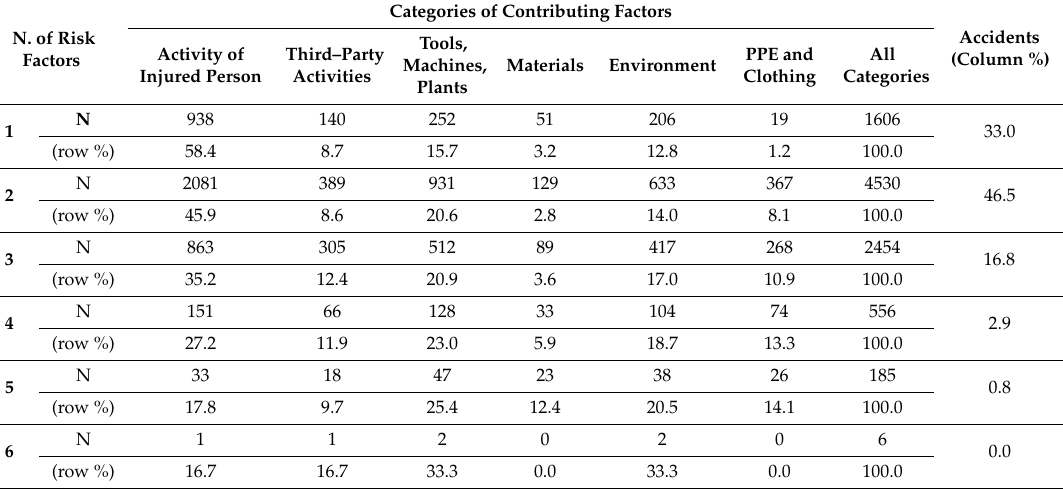
Table 7. Two-way classification of fatal occupational accidents by number of factors originating the accidents (rows) and category of contributing factors (columns). Number (N), percentage (%). PPE, Personal protective